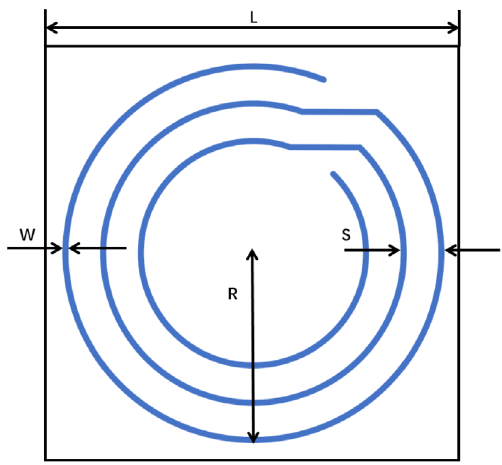
Fig. 6. Schematic diagram of NPM